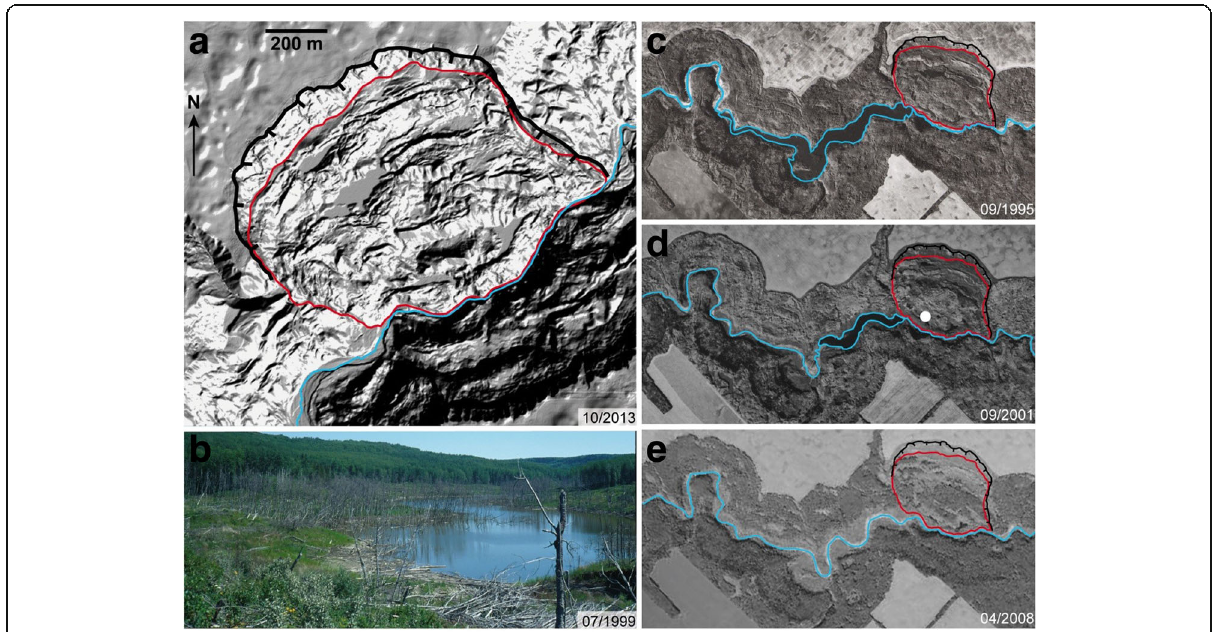
Fig. 12 The Saddle River landslide and dam. a . Digital Elevation Model derived using 2 m lidar data (dated October 22, 2013; source: Government of Alberta, reproduced with permission) showing the 1990 landslide colluvium (outlined in red) and mainscarp (black). b . The landslide lake in July 1999. Note the drowned timber within the landslide dam basin. (source: BGN Miller, July 1999.) c – e . Time series of aerial photographs showing the landslide dam lake in September 1995 and 2001, and the drained basin in August 2006 (air photos AS4680 – 33, AS5194B-40, and TRSG0602 – 1536 respectively; source: Alberta Environment and Parks, Air Photo Distribution, Copyright Government of Alberta, reproduced with permission). The white dot in d indicates the photograph location of b